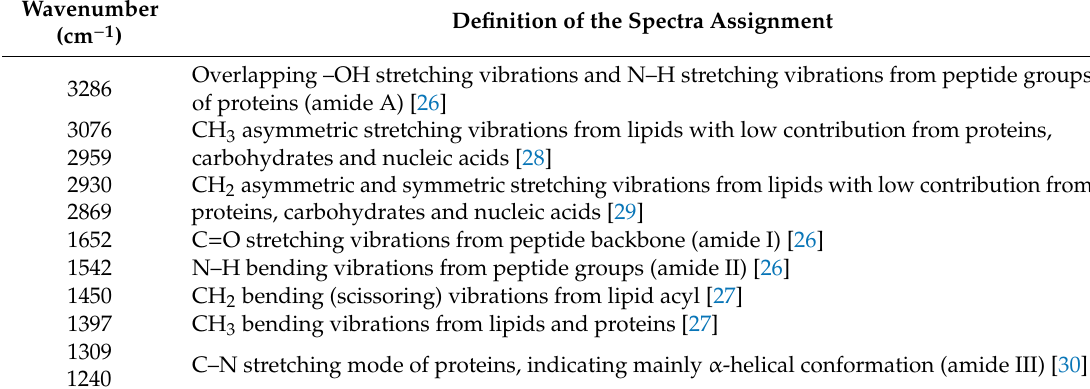
Table 2. FTIR peak